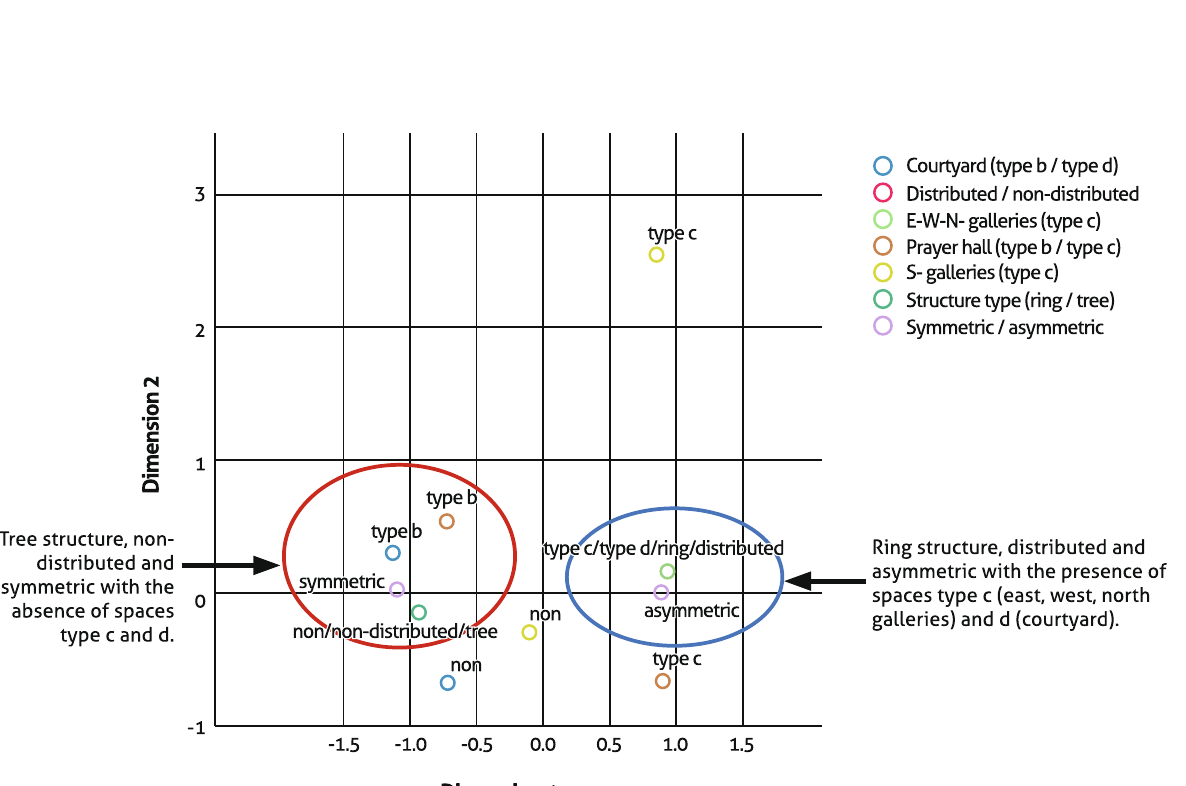
Fig. 7 Structure type (Source: the